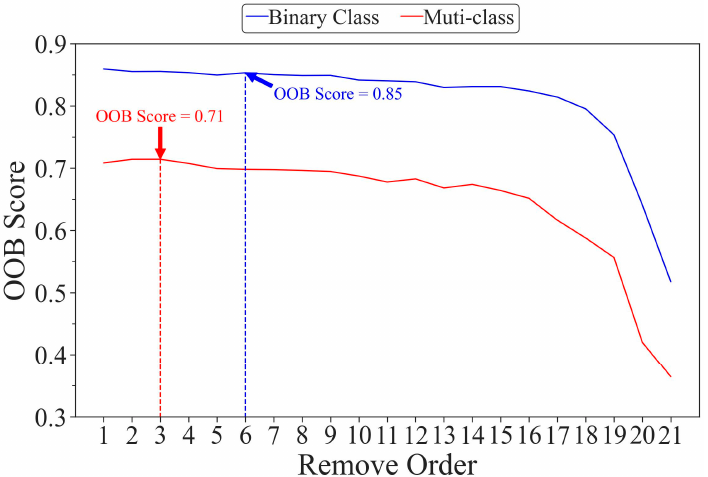
Figure 6. The OOB (out-of-bag) score of the random forest classification model used for rainfall/non- rainfall forecast (binary class, blue) and rainfall grade forecast (muti-class, red) changes along with the removal of undetermined features. The corresponding feature removal sequence of each model is shown in Table 2.